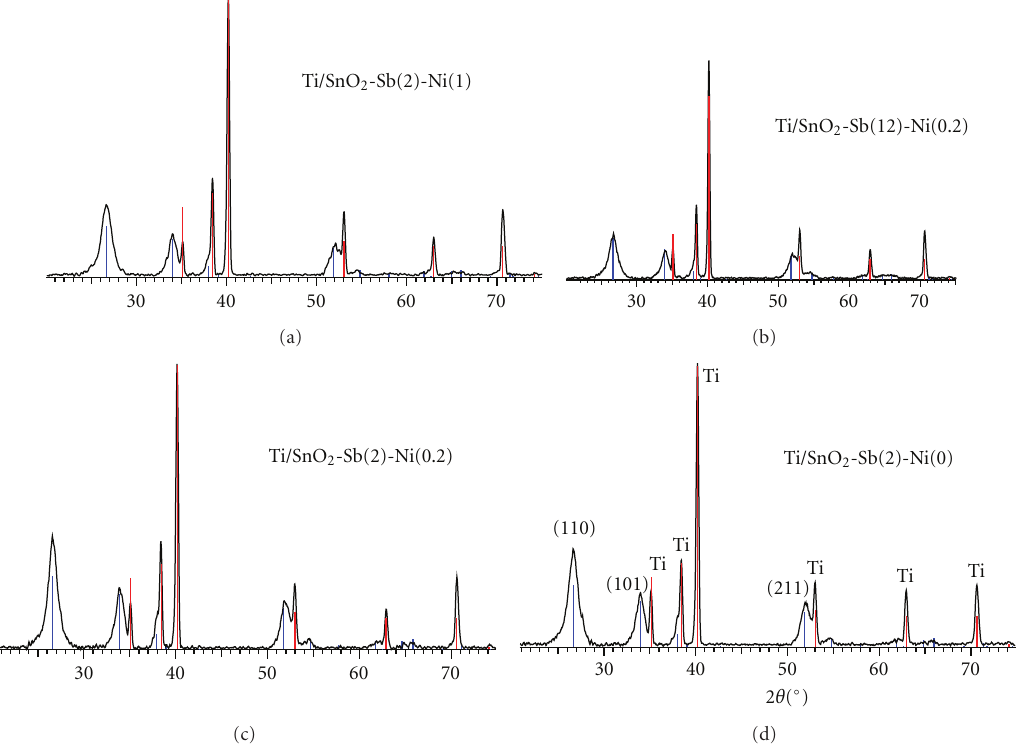
Figure 10: Typical XRD patterns of Ti / SnO 2 -Sb-Ni electrodes with di ff erent amounts of antimony and nickel. The values in parentheses are atomic ratios in % with respect to Sn. The peaks marked with blue lines are related to SnO 2